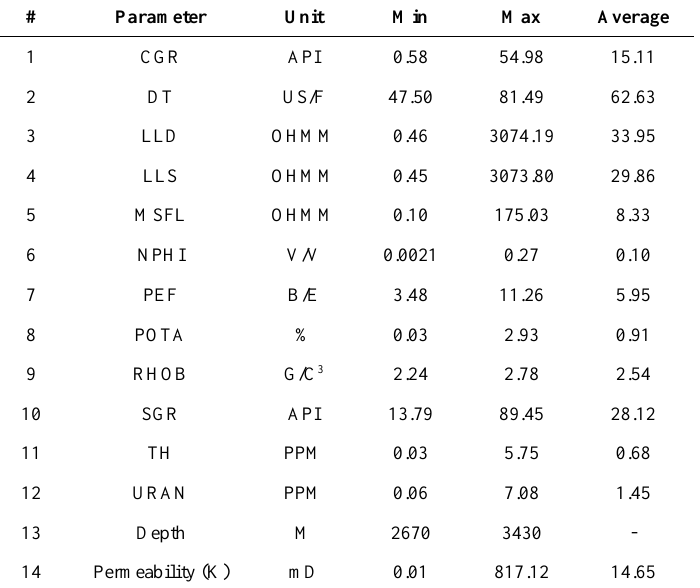
Table 1. Input and output data with the minimum, maximum, and average